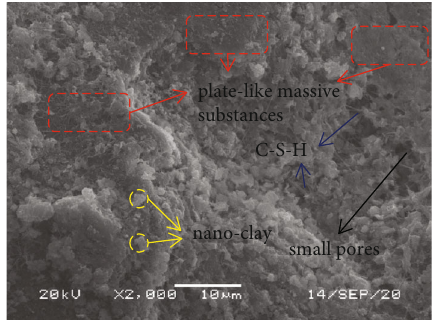
Figure 9: Microscopic features of